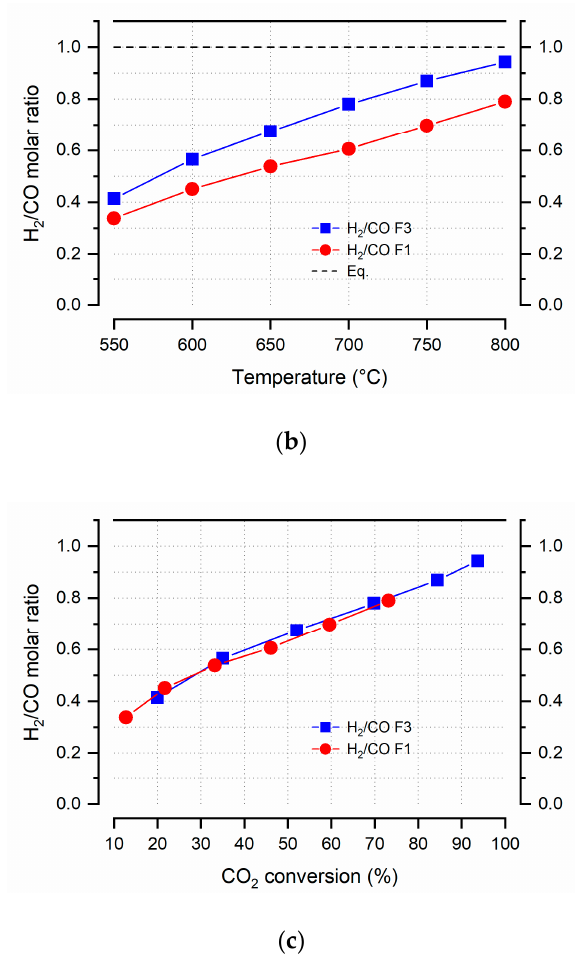
Figure 7. ( a ) CH 4 and CO 2 conversion (%) as a function of temperature, ( b ) the corresponding H 2 / CO molar ratio, ( c ) H 2 / CO molar ratio as a function of CO 2 conversion (%). Reaction conditions: CH 4 / CO 2 = 1, P = 1.3 bar, GHSV = 94,000 h − 1 (F1), GHSV = 31,000 h − 1 (F3). Equilibrium conversion is also indicated with the dashed line.